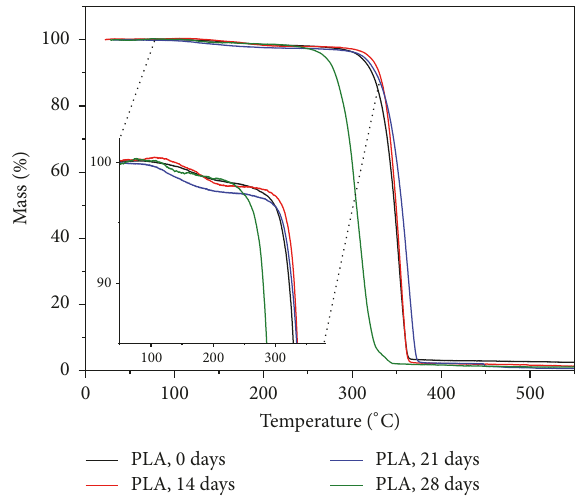
Figure 6: TGA thermograms of the PLA samples with different in vivo exposure